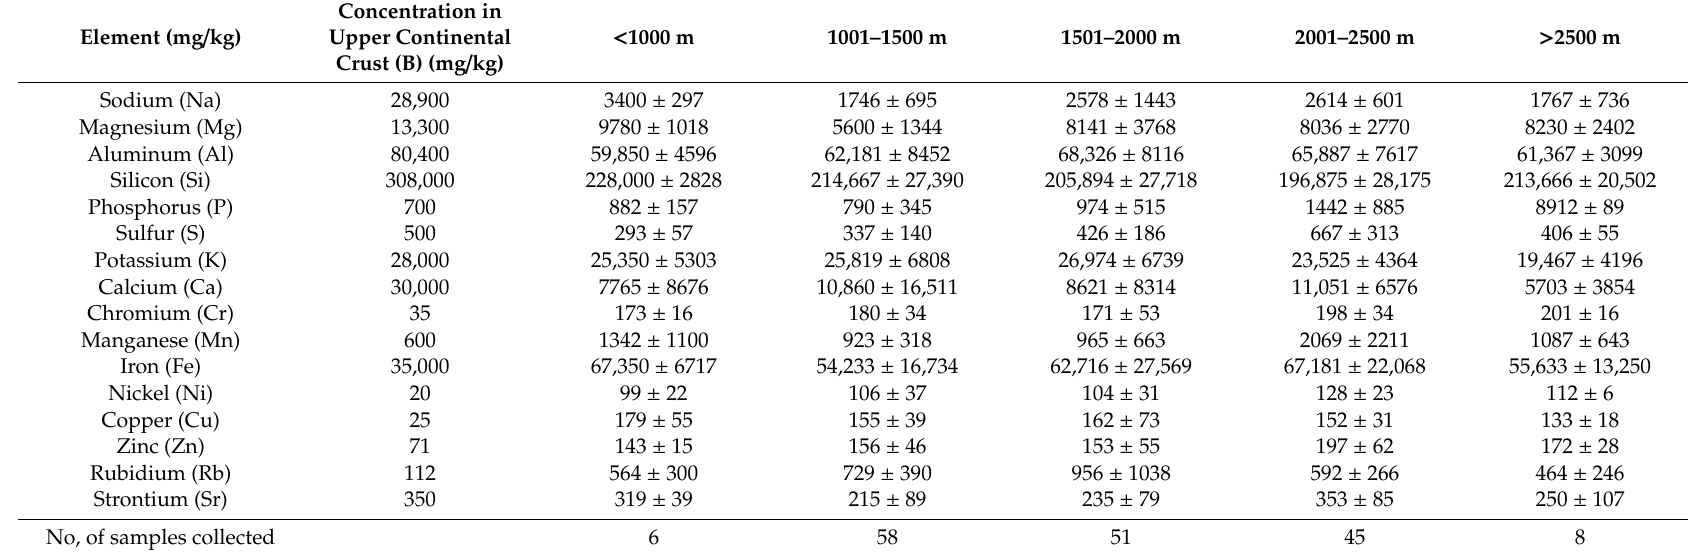
Table 1. Chemical elements concentration of soil (mean ± SD) vs.